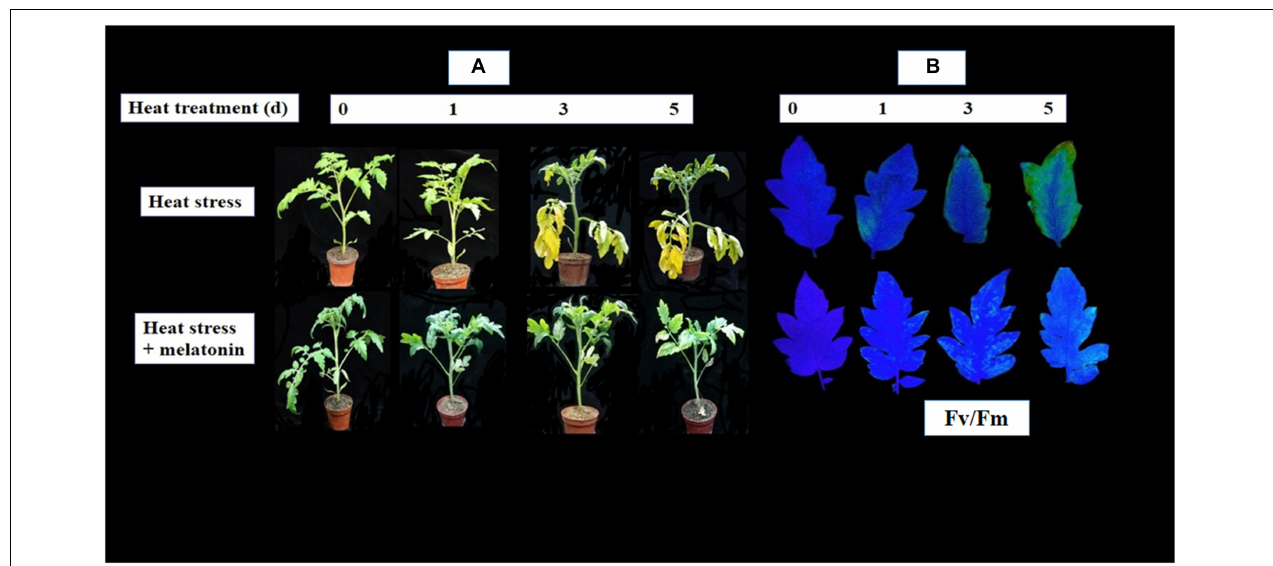
FIGURE 1 | Exogenous application of melatonin (100 µ M) delays heat induced (38/28 ◦ C for 5 days) leaf senescence in tomato. (A) Phenotypic appearance of tomato leaves during heat stress in presence or absence of melatonin treatment and (B) Chlorophyll fluorescence imaging with Fv/Fm of tomato leaves during heat stress in presence or absence of melatonin treatment.